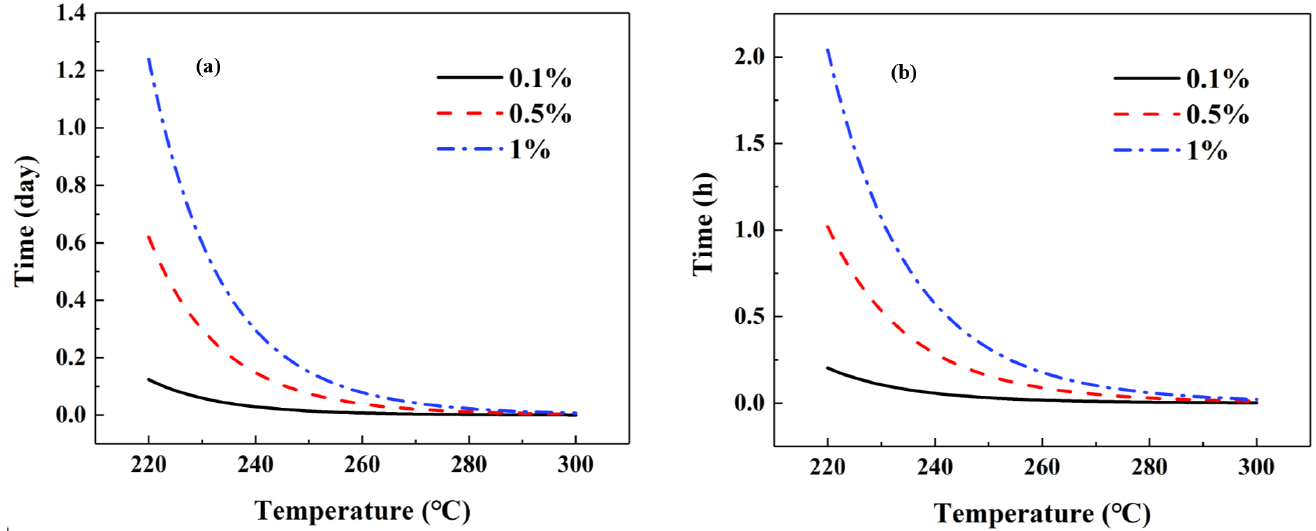
Figure 7. Predicted iso-conversion plots of the unfilled matrix resin ( a ) and Ag-filled ICA ( b ).